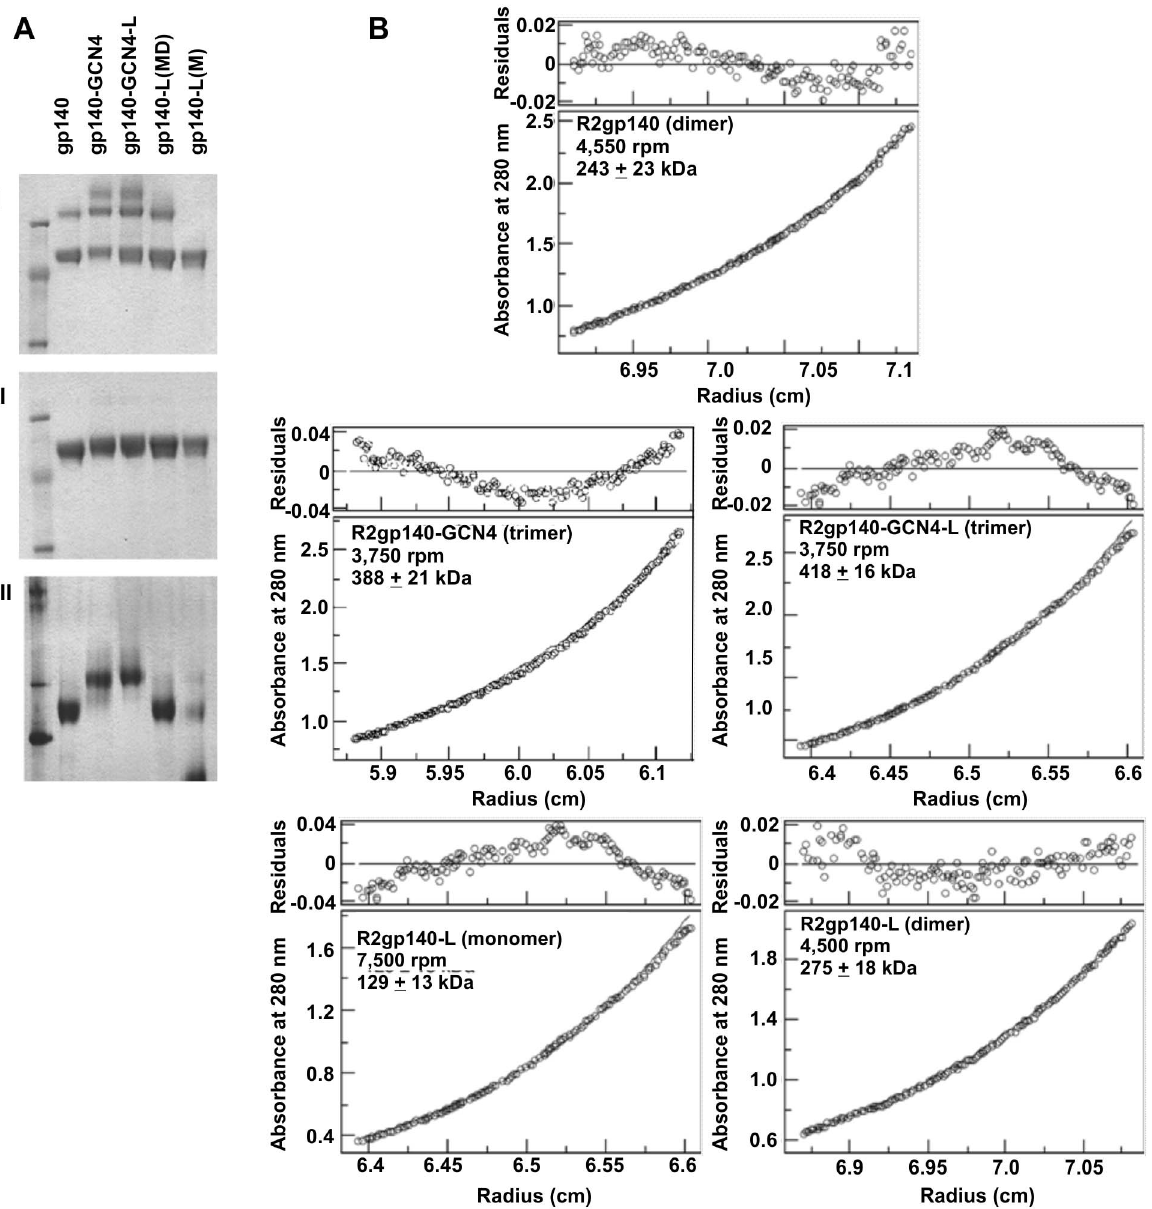
Figure 1. Purified oligomeric R2 HIV-1 envelope glycoproteins. (A) Three m g of each purified protein was loaded in each lane. Upper Panel: samples were treated with reducing SDS-PAGE sample buffer, boiled, separated by SDS-PAGE, and stained with coomassie blue. Lower Panel: samples were treated and separated using 3–12% Blue Native PAGE (In Vitrogen). Both the R2gp140-GCN4 and R2gp140- GCN4-L migrated as trimer with MW , 720 kDa, whereas the wild-type R2gp140 migrated as . 90% dimer with a MW of , 520 kDa. (B) Size estimation of the differing forms of R2 gp140 was further estimated by analytical ultracentrifugation. The R2 gp140 preparations used in Figure 1A were subjected to sedimentation equilibrium analyses by ultracentrifugation. The identity of the gp140 form tested, centrifuge speed for equilibrium determination, and estimated molecular mass of each is shown in the inset in each panel.